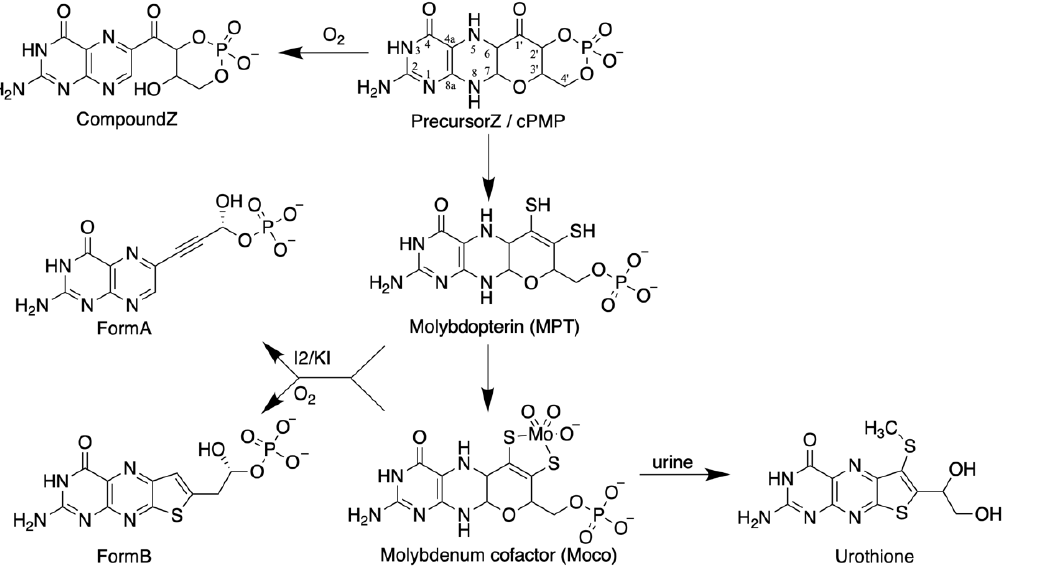
Figure 1. Structures of PrecursorZ, molybdopterin (MPT), Moco, and their derivatives. PrecursorZ is cyclic pyranopterin monophosphate (cPMP), and CompoundZ is its air-oxidized product. MPT and Moco are both 5,6,7,8-tetrahydropyranopterins. FormB is the air-oxidized degradation product of MPT and Moco, whereas FormA is the iodine-oxidized derivative. FormA and FormB are shown in their phosphorylated forms. Urothione is the degradation product of Moco in humans, which is excreted in the urine.